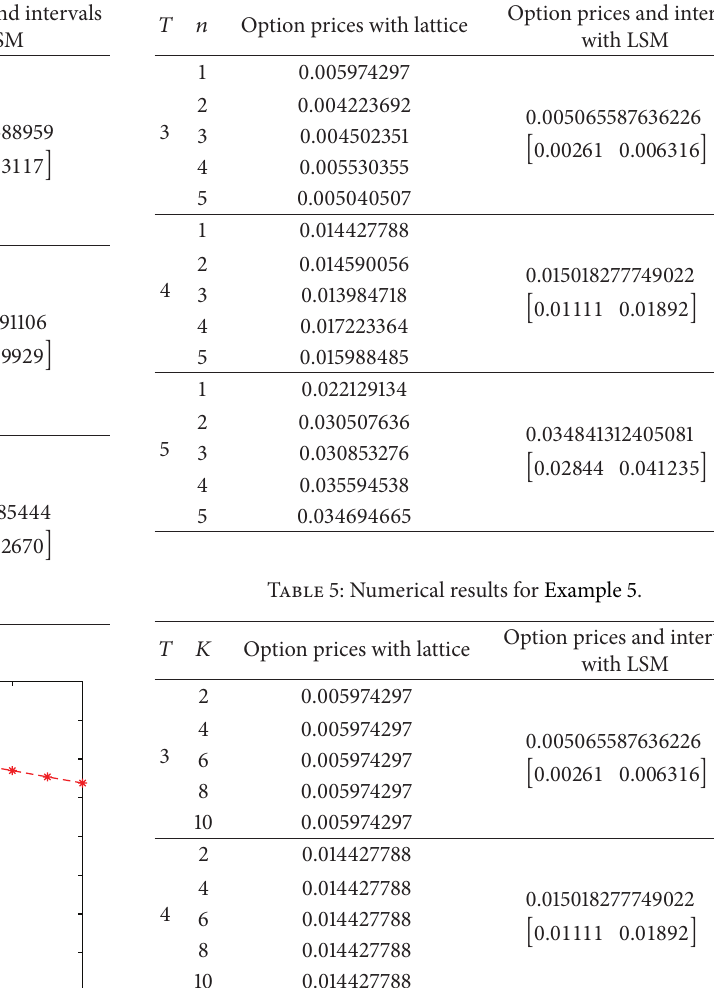
Table 3: Numerical results for Example 2.